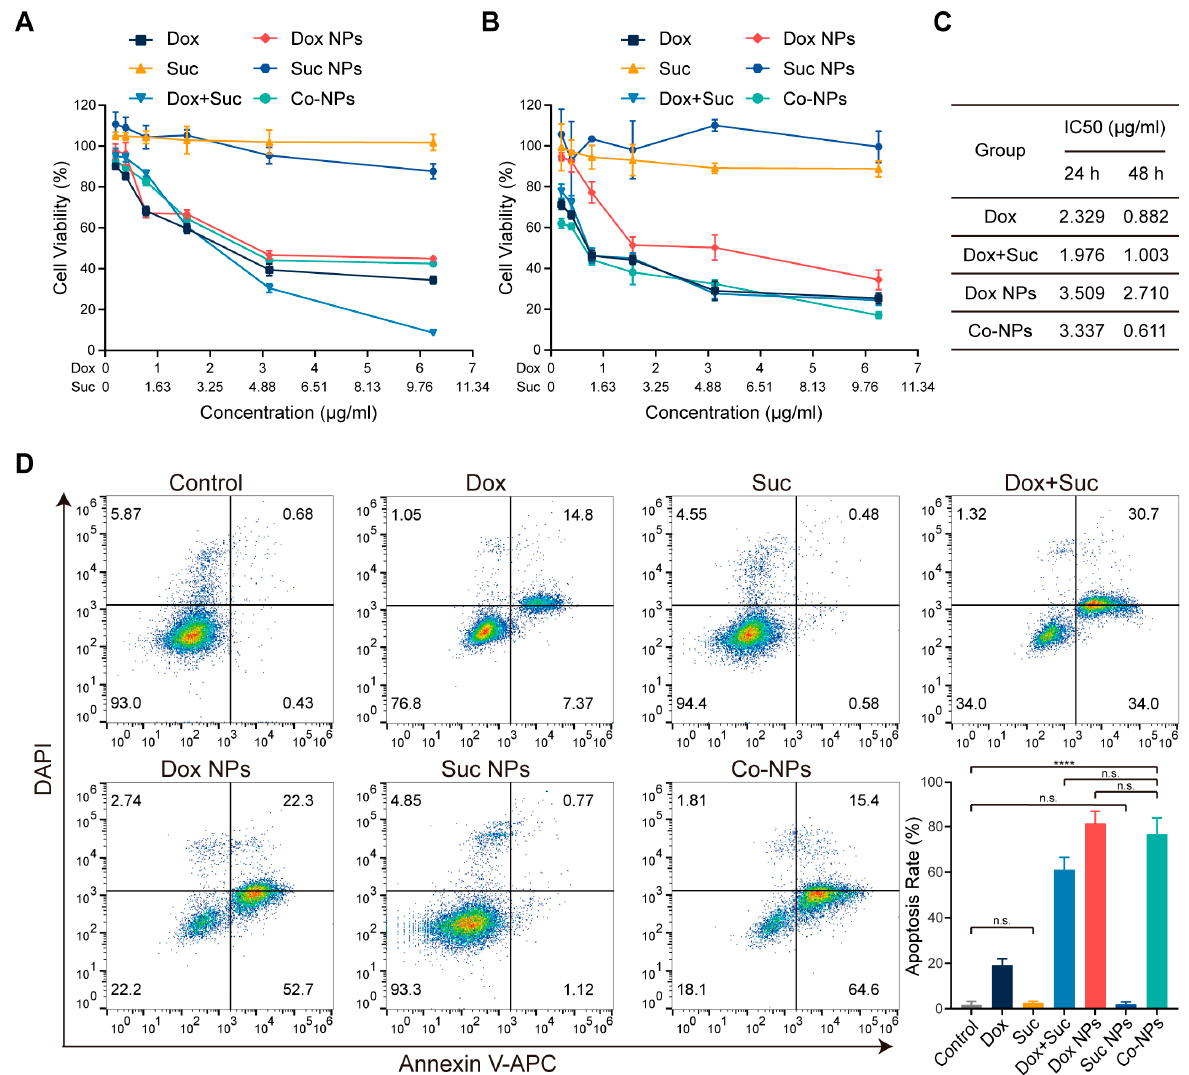
Figure 3. In vitro cytotoxicity and apoptosis. ( A , B ) In vitro cytotoxicity of Dox, Suc, Dox + Suc, DOX NPs, Suc NPs, and Co-NPs against B16F10 cells within 24 h ( A ) and 48 h ( B ), respectively ( n = 3). ( C ) IC50 values of different free drugs and nanoparticles within 24 and 48 h. ( D ) In vitro apoptosis of B16F10 cells induced by Dox, Suc, Dox + Suc, Dox NPs, Suc NPs, and Co-NPs within 24 h ( n = 3). (n.s., not significant, **** p <